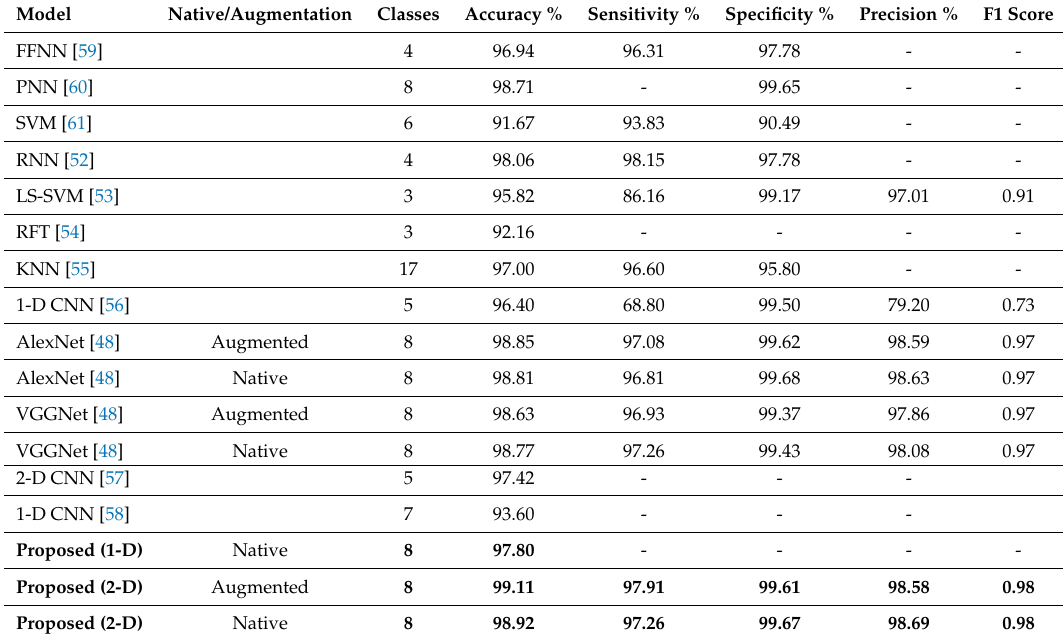
Table 4. Comparison of the proposed model with state-of-the-art ECG classification techniques.